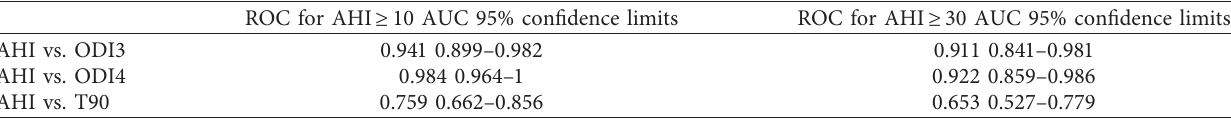
Table 3: Receiver operating characteristic calculations using the polygraphy apnea-hypopnea index as the reference standard. ROC for AHI ≥ 10 AUC 95% confidence limits